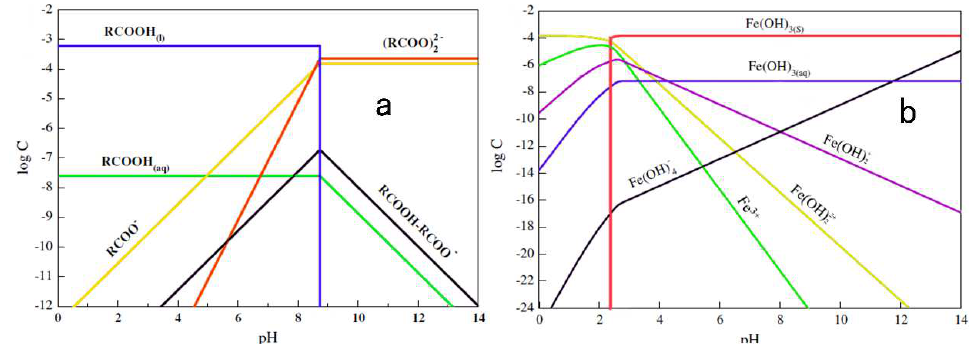
Figure 4. Flotation recovery of minerals as a function of pH. ( a ) NaOL concentration under natural pH ( b ); Fe 3+ concentration under natural pH ( c ); the adsorption as a function of NaOL ( d ).